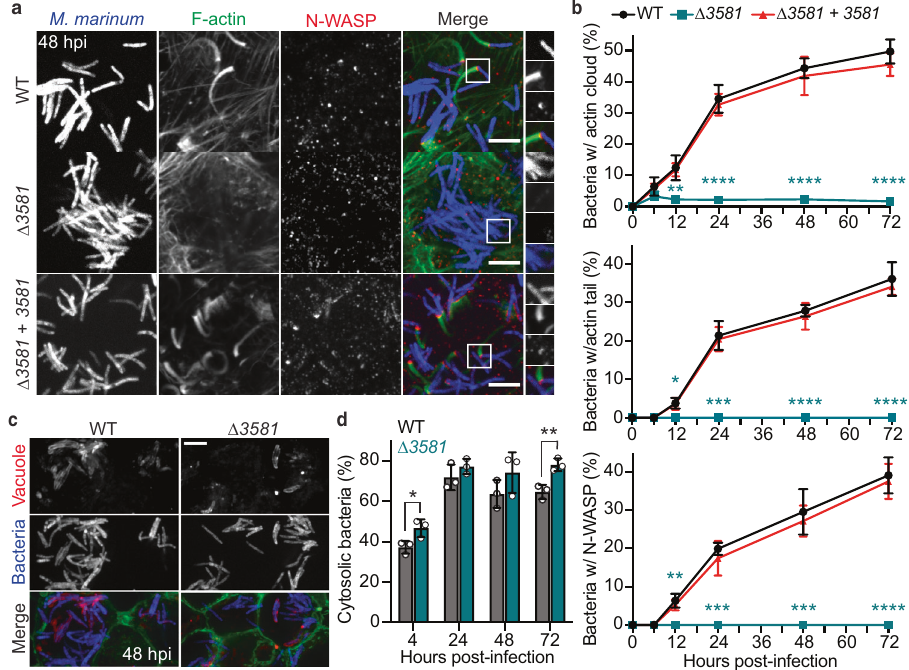
Fig. 2 Δ MMAR_3581 bacteria escape into the host cytosol but are unable to recruit N-WASP to the bacterial surface. a Micrographs depicting the ability of indicated M. marinum (blue; EBFP2) strains to recruit N-WASP (red; anti-N-WASP) and stimulate actin polymerization (green; Alexa 488 phalloidin) in U2OS host cells at 48 hpi. Scale bar is 5 µ m and images are representative of three independent experiments. b Time course graphs of indicated M. marinum stains colocalized with either actin clouds, actin tails, or N-WASP. c Representative micrographs of indicated M. marinum (blue; EBFP2) strains enveloped by a vacuole (red; CM-DiI) in Raw 264.7 cells (green; Alexa 488 phalloidin) at 48 hpi to examine cytoplasmic access. Scale bar is 3 µ m. d Quanti fi cation of cytoplasmic access for indicated M. marinum strains during infection of Raw 264.7 cells at indicated time points. Data in b , d are mean ± SD; n = 3 independent experiments. Data in b used a one-way ANOVA with post hoc Tukey test where each group was compared to wild type and data in d used an unpaired two-tailed t test; * p < 0.05, ** p < 0.01, *** p < 0.001, and **** p < 0.0001. Source data are provided as a Source data fi